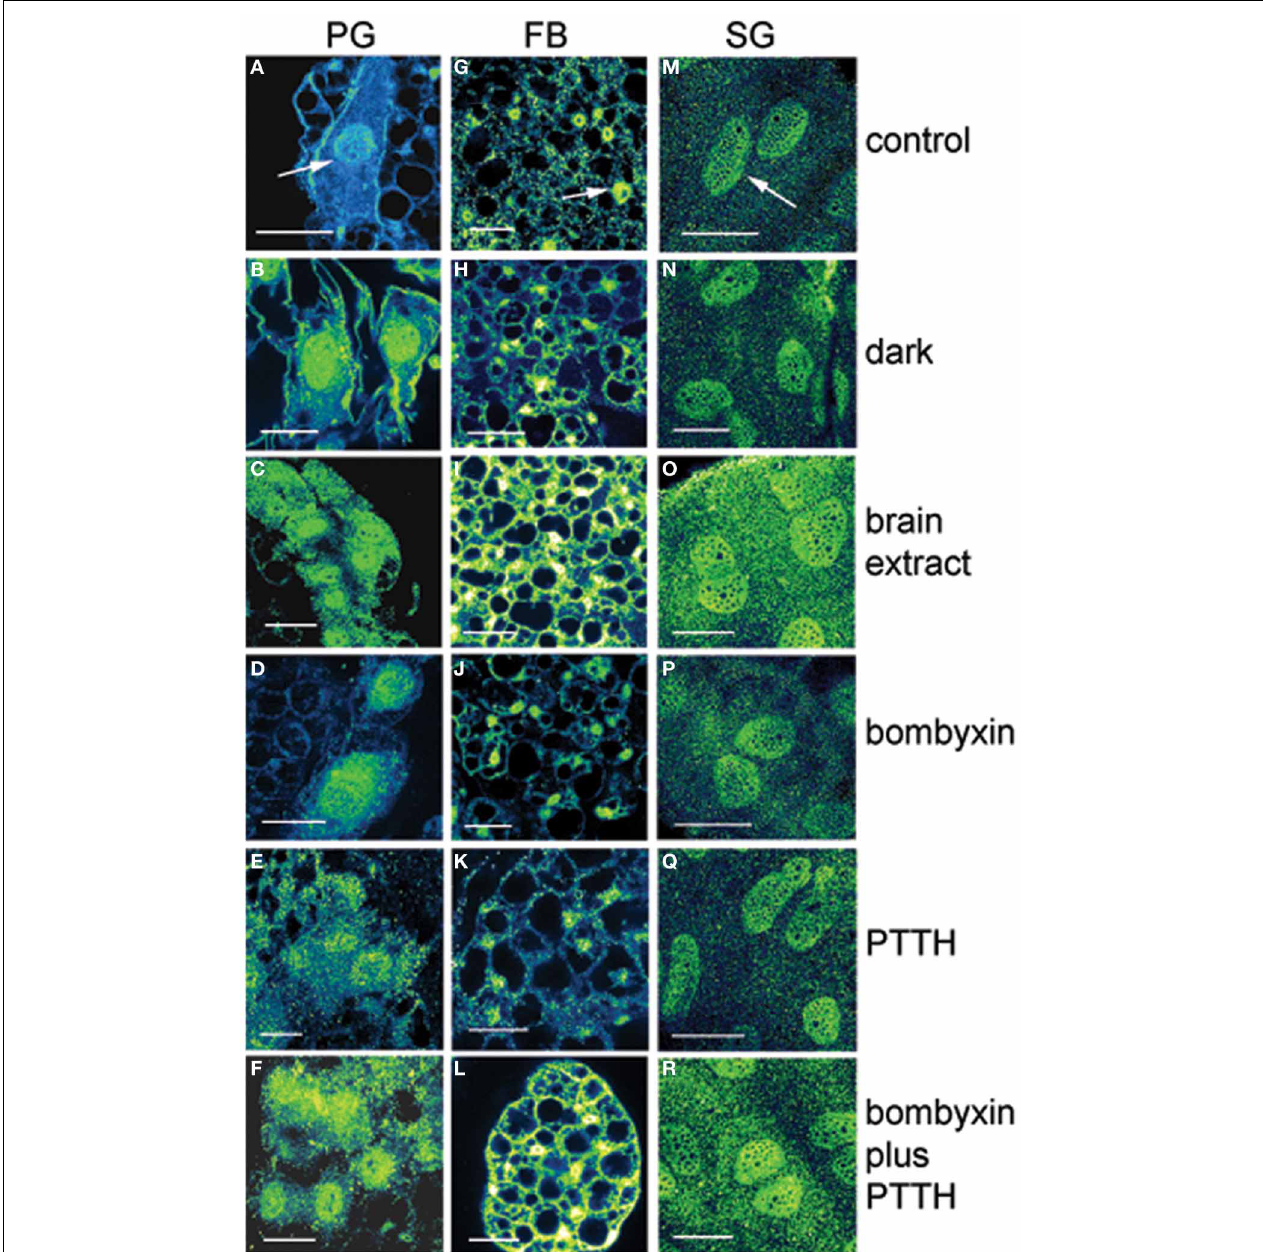
FIGURE 2 | Effects of various treatments in vitro on PER immunofluorescence in PG cells (A–F), FB cells (G–L), and SG cells (M–R) from arrhythmic LL animals at day 12 after feeding. Fluorescence in shown as green/yellow. Arrows in (A,G,M) show nuclei. Controls were incubated in light. In PG cells note the substantial increase in nuclear immunofluorescence intensity following all treatments compared to controls.